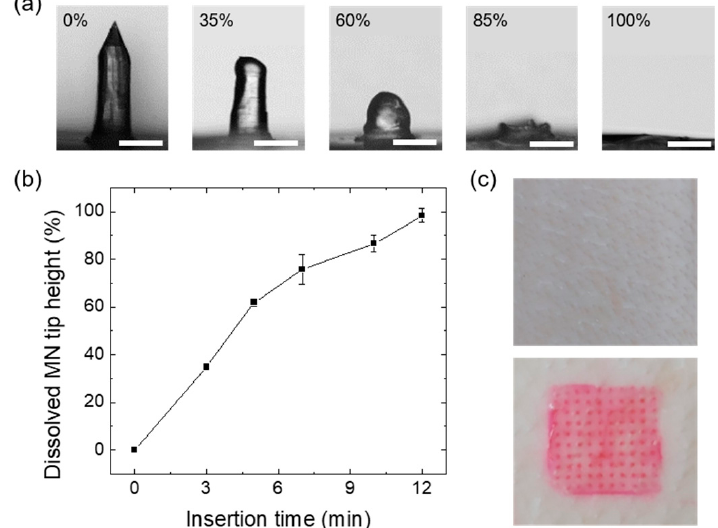
Figure 5. ( a ) Optical microscopic images of GSH-MN taken before (0%) and after partial dissolution (35%, 60%, 85%, and 100%) of the MN tip following application into porcine skin (scale bar = 200 µm). ( b ) Plot for the dissolved tip height as a function of insertion time. ( c ) Photographic images showing the porcine skin before (top) and after (bottom) application of the dye-loaded GSH-MN patches.